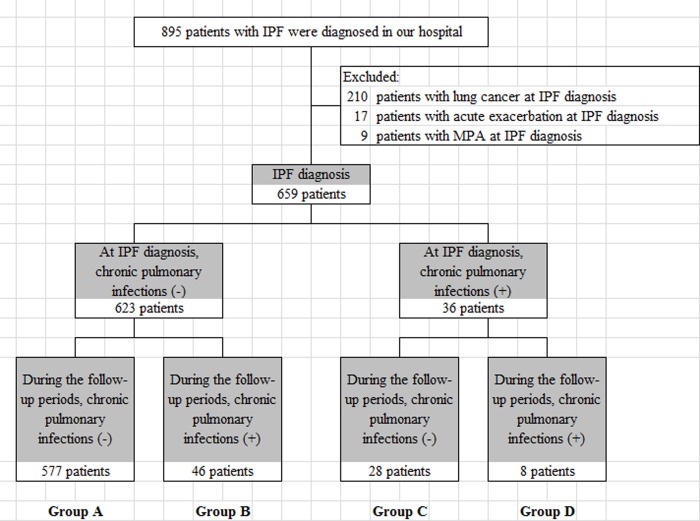
Diagram of the patients with or without CPI at IPF diagnosis or the follow-up period.MPA = microscopic polyangiitis.